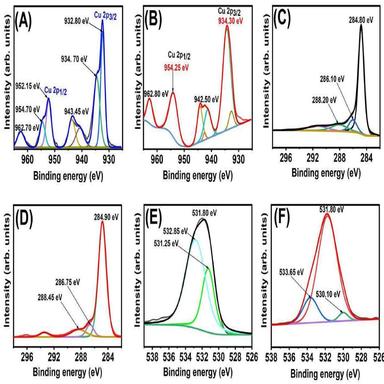
Deconvoluted high-resolution XPS spectra of (A) Cu 2p in Cu np (B) Cu 2p in Cu-ACC (C) C 1s in ACC (D) C 1s in Cu-ACC (E) O 1s in ACC and (F) O 1s in Cu-ACC.